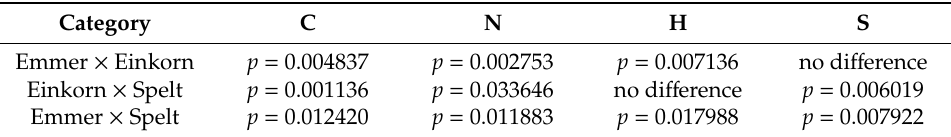
Table 5. Statistical evaluation—post-hoc Tukey HSD